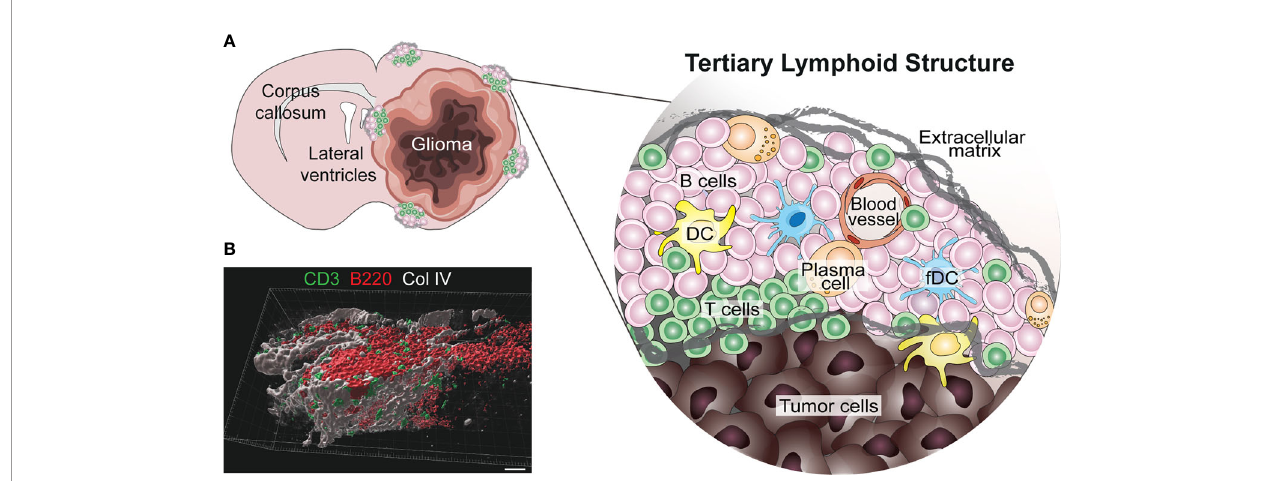
FIGURE 1 | Known location and composition of TLS in murine glioma. (A) The image shows a schematic representation of the location and composition of TLS in murine glioma models (12). TLS form in the meningeal and ventricular regions of the tumor-bearing hemisphere, either in direct contact with the tumor or in its proximity. These structures form around blood vessels and are composed of B cells, T cells, dendritic cells (DCs), follicular DCs (fDCs) and a few plasma cells. Interestingly, murine glioma-associated TLS are surrounded by a network of extracellular matrix. (B) A 3D rendering of a cortical TLS (identi fi ed by B220 + B cells in red and CD3 + T cells in green) formed in a treatment-naïve GL261 glioma-bearing mouse, indicating how the structure is surrounded by a network of collagen IV (Col IV) in grey (scale bar 30